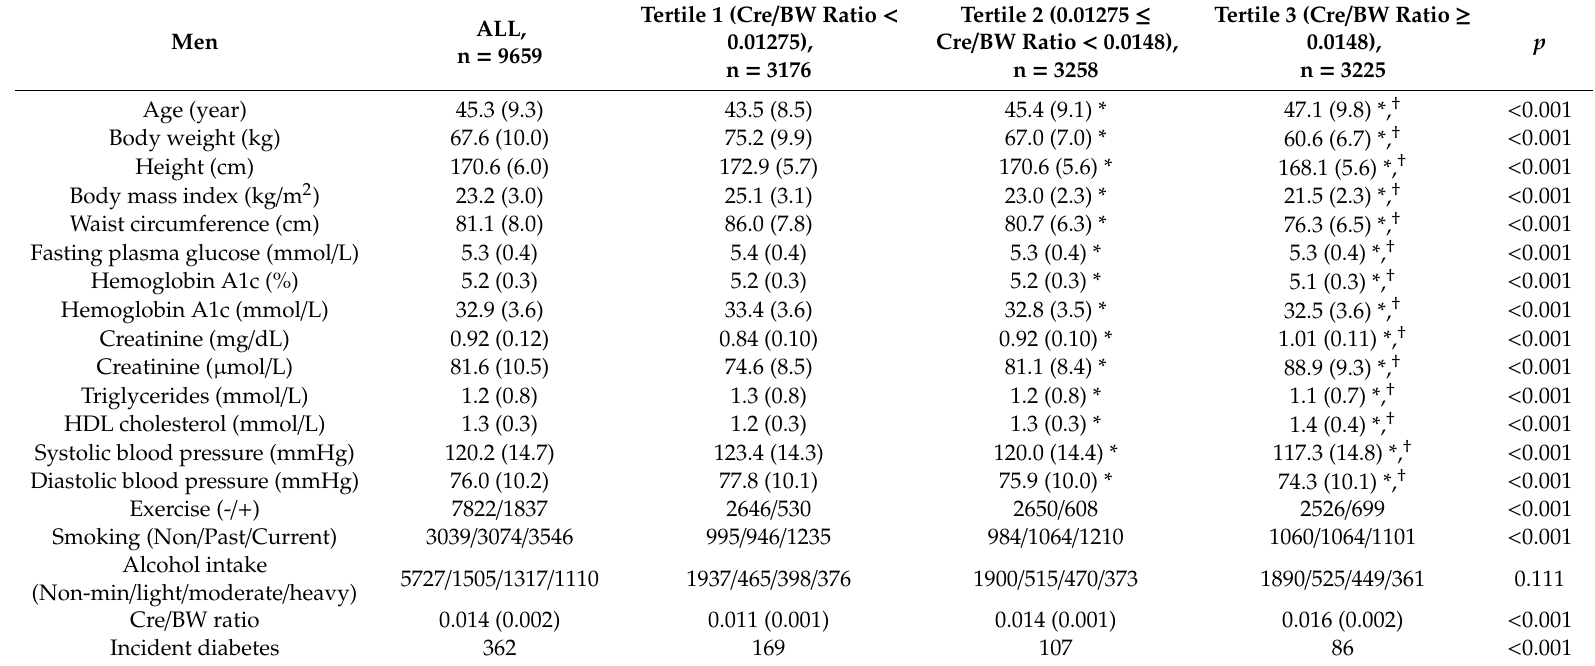
Table 1. Baseline characteristics of study participants according to the tertiles of creatinine / body weight (Cre / BW)